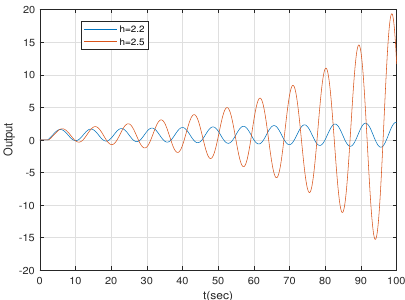
Figure 10. Unit step responses of Example 3 for h=2.2 and h=2.5